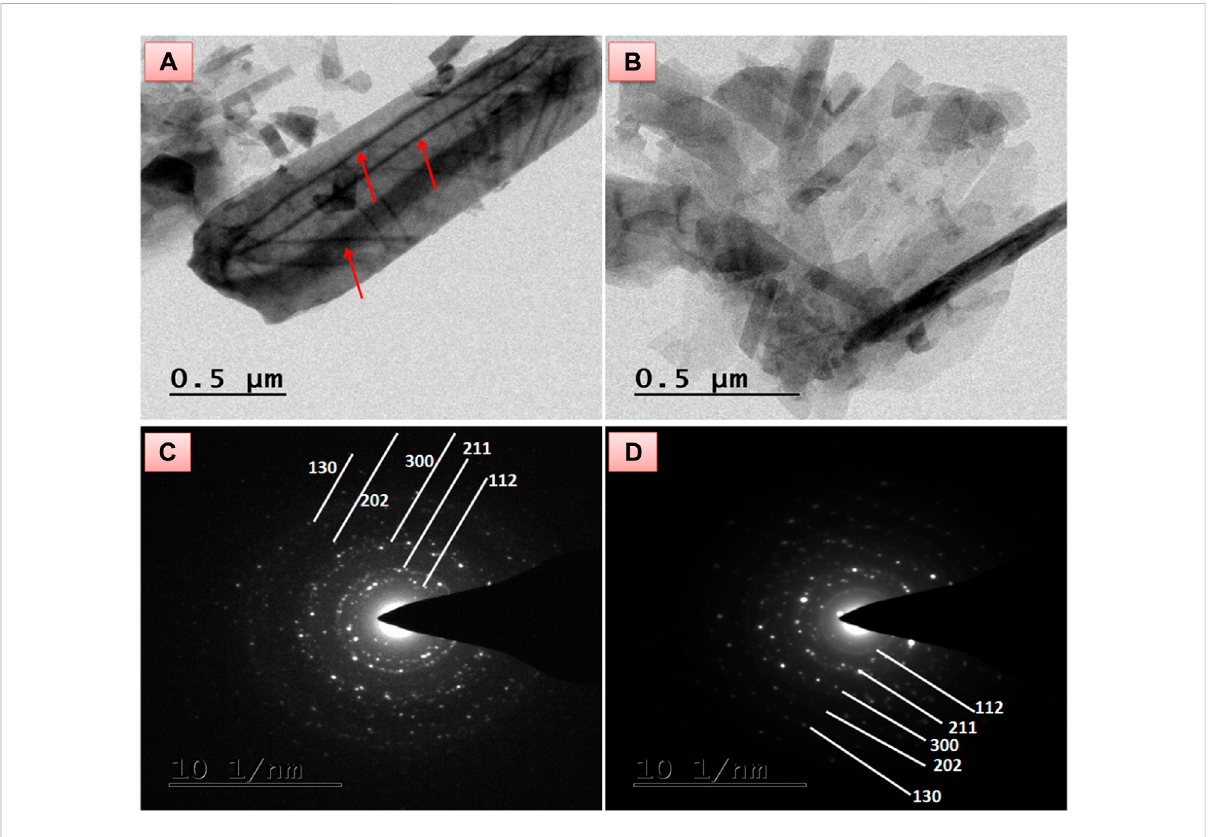
FIGURE 4 TEM morphology of (A) HAP/COL/CCQD composite (B) HAP/COL/CCQD/CRN composite, and the SAED pattern of (C) HAP/COL/CCQD composite, (D) HAP/COL/CCQD/CRN